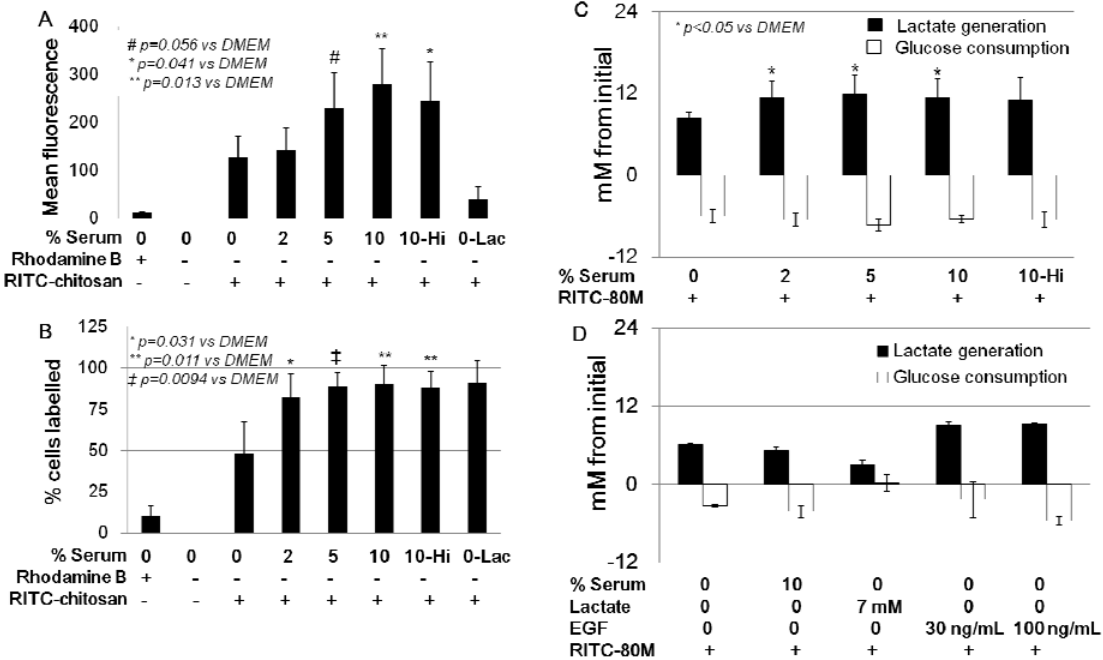
Figure 11. Quantitative flow cytometry analysis of HEK293 cells ( A – B , mean fluorescence and % cells labeled), and lactate generation ( C – D ) after 24 h of culture with RITC-80M chitosan in media with different levels of serum (0%, 2%, 5%, 10%), exogenous lactate or EGF. 10-Hi: 10% heat-inactivated serum; 0-Lac, DMEM+7 mM